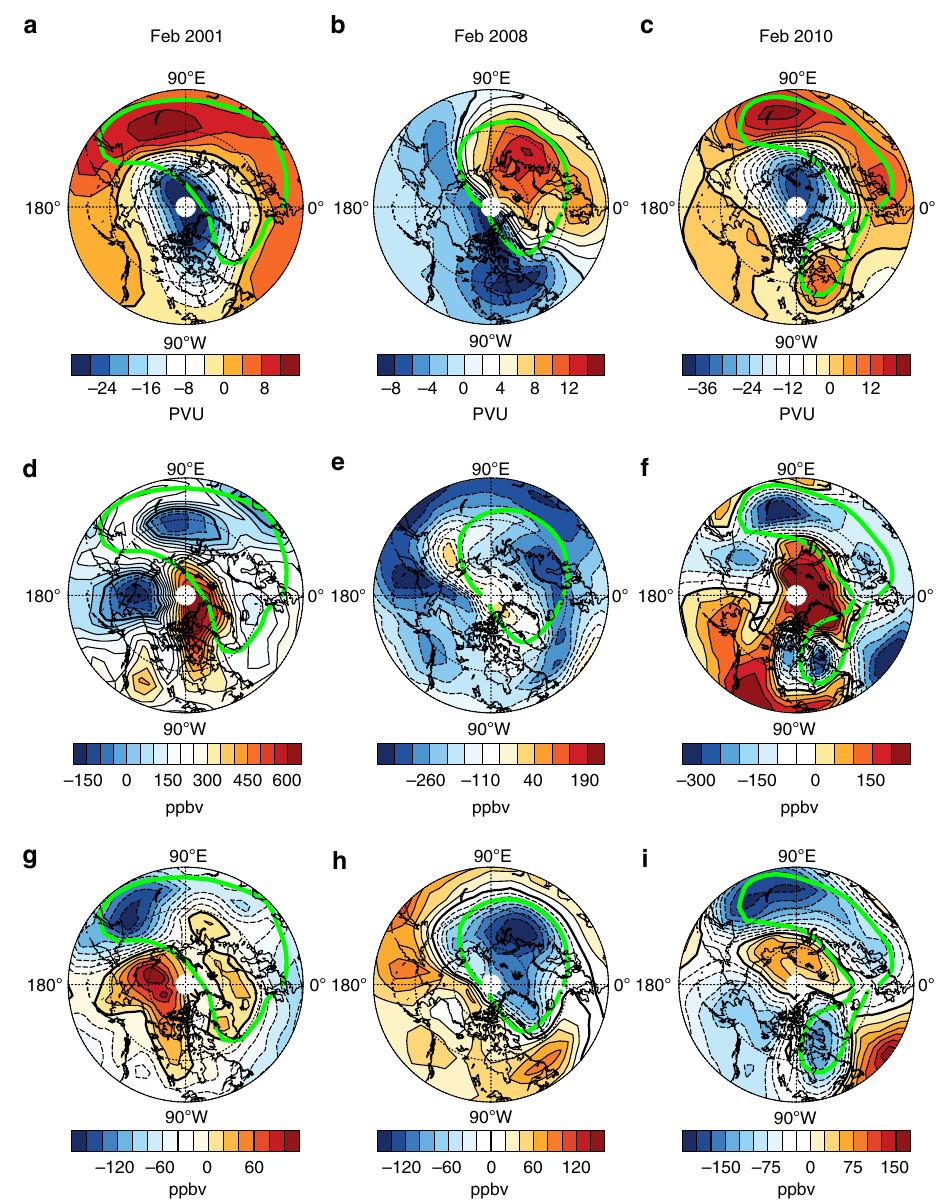
Fig. 3 Potential vorticity and stratospheric ozone anomalies. Isentropic potential vorticity (PV) anomalies in February during a 2001, b 2008 and c 2010 with respect to the climatology averaged over the isentropic layers from 430 to 600 K. Panels d – f are the same as a – c , but for dynamical ozone anomalies from SLIMCAT. Panels g – i are the same as a – c , but for heterogeneous chemical ozone anomalies from SLIMCAT. The green contour lines represent the edges of the polar vortex. The minimum latitude of polar stereographic projections is